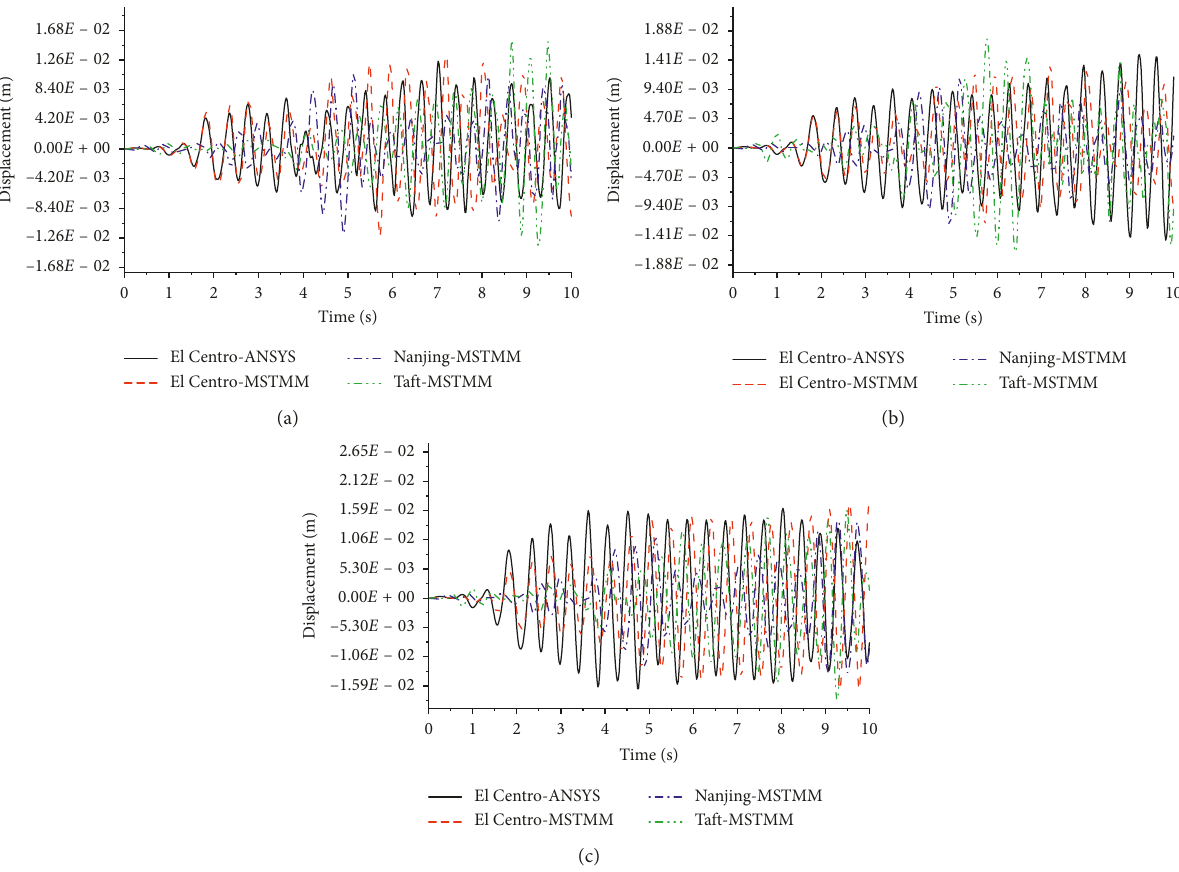
a 1 , 15 displacement under seismic wave (peak acceleration is 35cm/s